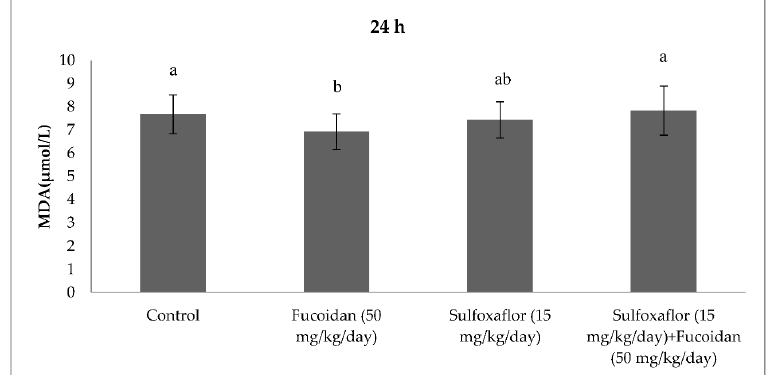
Figure 2. Effects of Sulfoxaflor and Fucoidan on 8-OHdG Levels (ng/mL) in Serum of Mice at 7-d Treatment Periods. Values are expressed as mean±standard error. 8-OHdG: 8-hydroxy-2’-deoxy- guanosine. Letters a, b and c show the differences between treatment groups and control. Data shown in different letters are significantly different at p < 0.05 level ( n = 8). Duncan multiple com- parison tests were used.